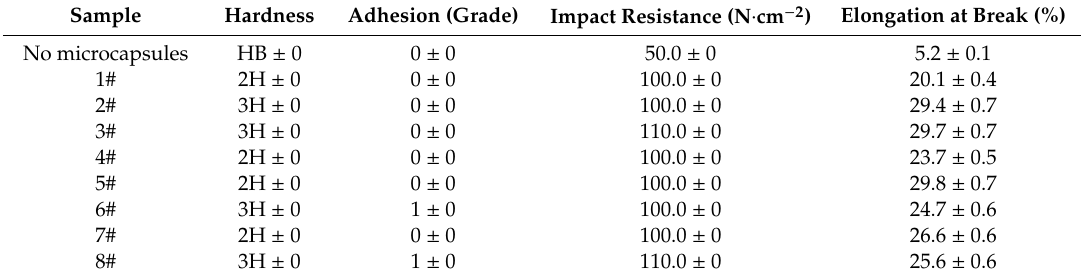
Table 5. E ff ect of the coating process on the mechanical properties of the paint film with microcapsules. Sample Hardness Adhesion (Grade) Impact Resistance (N · cm − 2 ) Elongation at Break